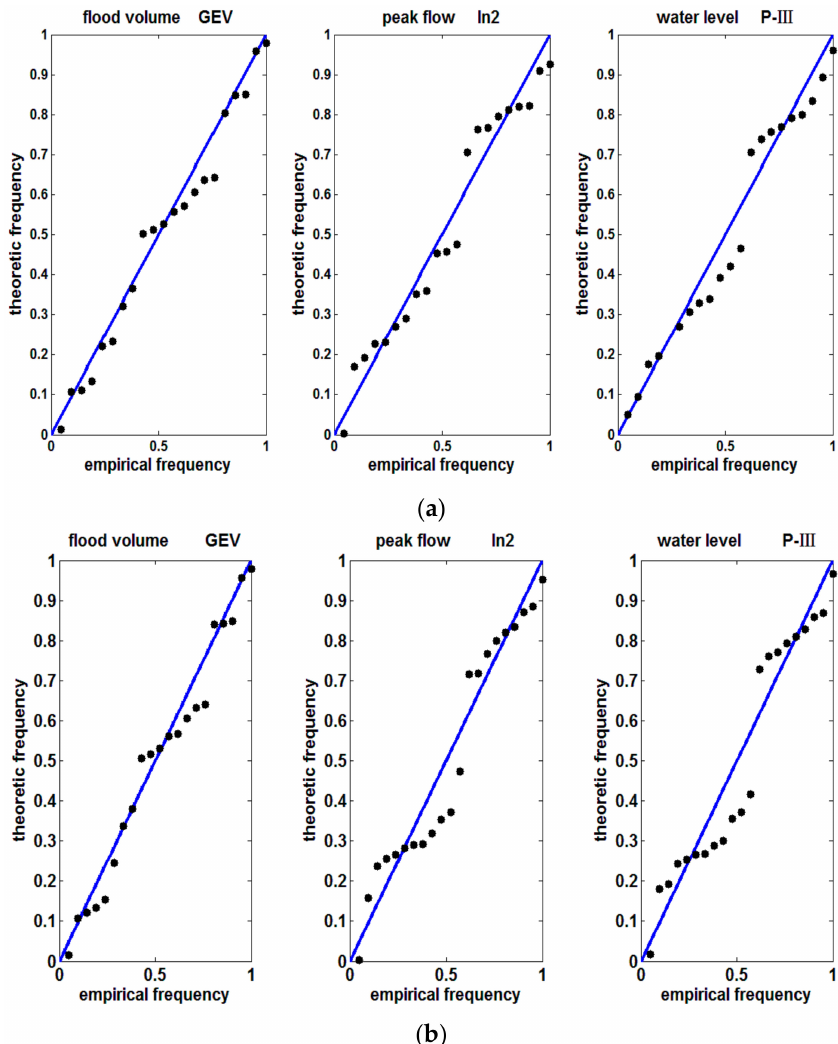
Figure 4. The correlation of empirical and theoretical frequency of marginal distribution: ( a ) The marginal fitting plots of the flood variables without UAPs; ( b ) the marginal fitting plots of the flood variables with UAPs.